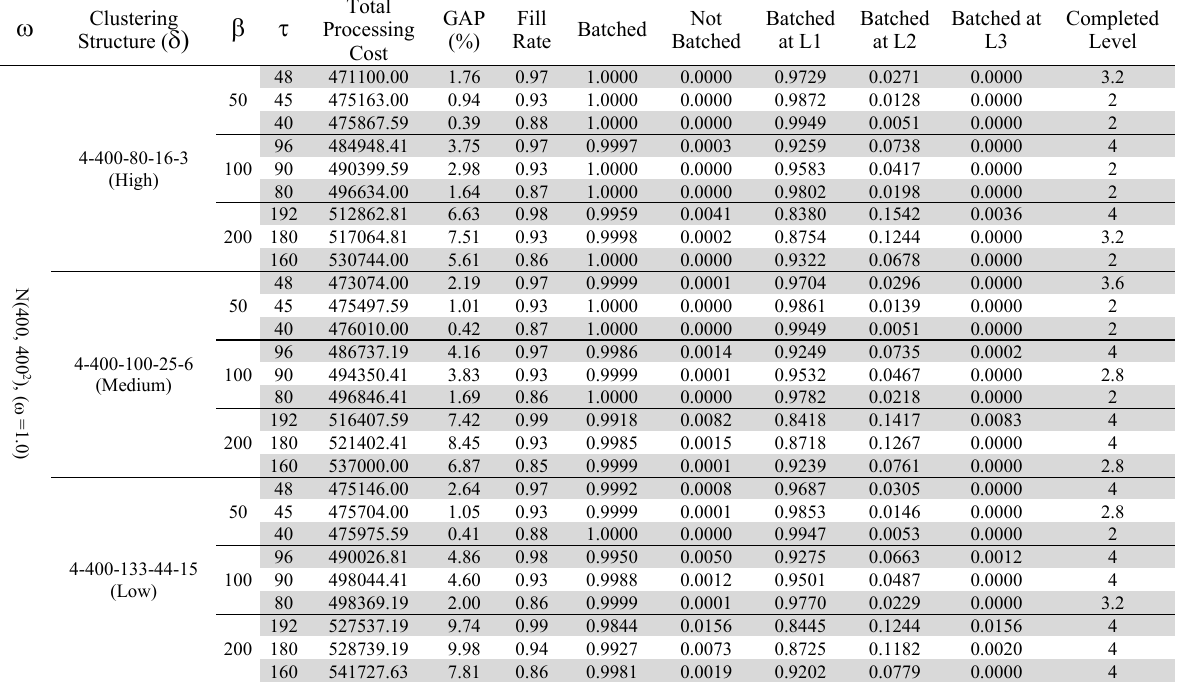
Results for demand scenario S-1 with 4-Level non-exclusive